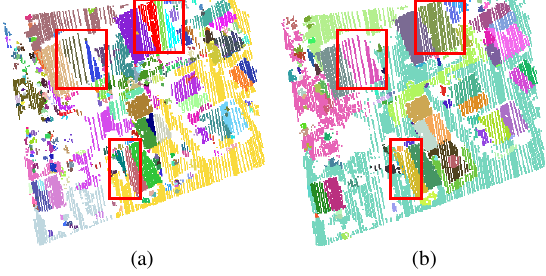
Figure 8. Airborne LiDAR dataset segmentation results: (a) without considering local point density variations and (b) considering local point density